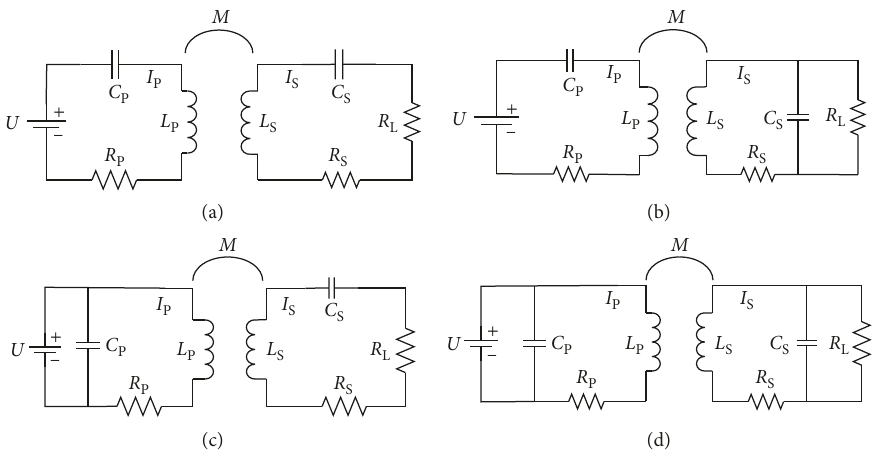
Figure 2: Four basic resonant compensation structure circuits: (a) SS mode; (b) SP mode; (c) PS mode; (d) PP